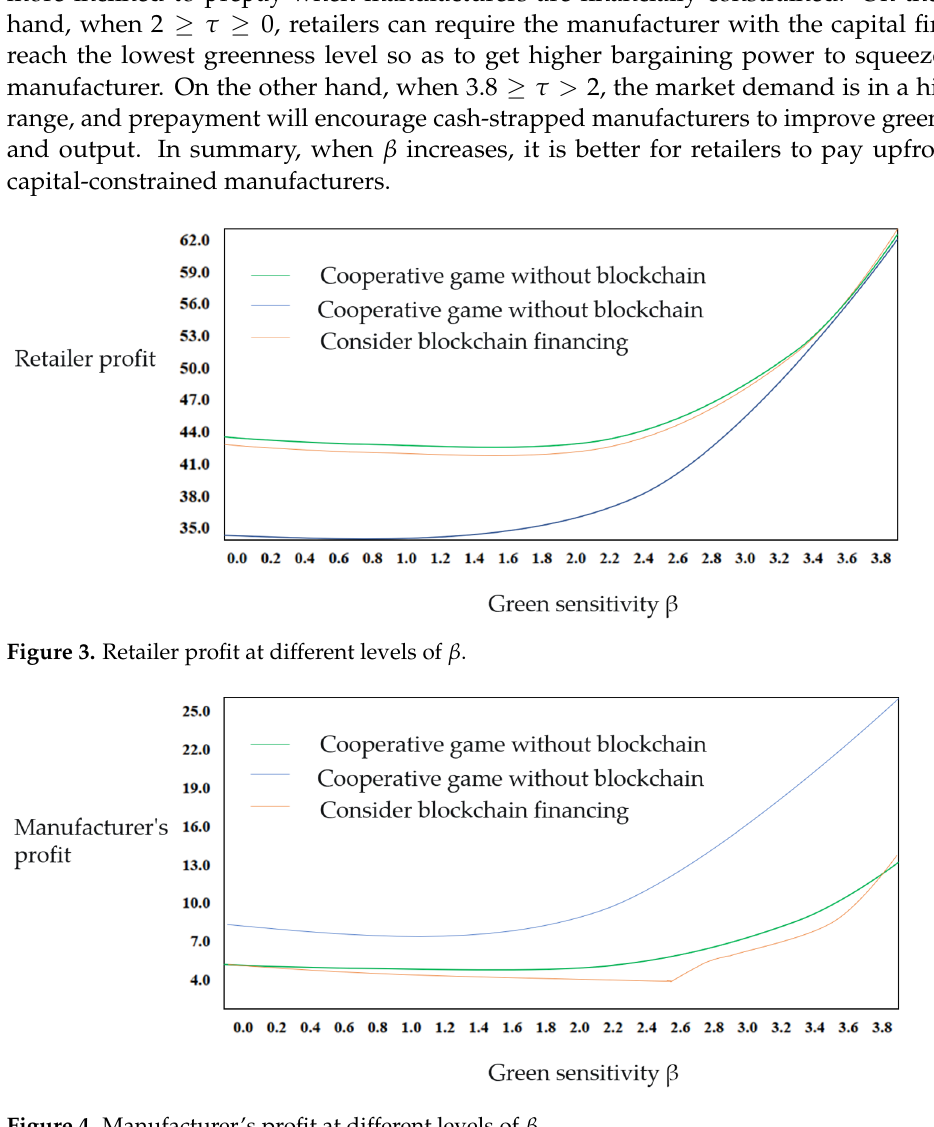
Figure 4. Manufacturer’s pro fi t at di ff erent levels of β .